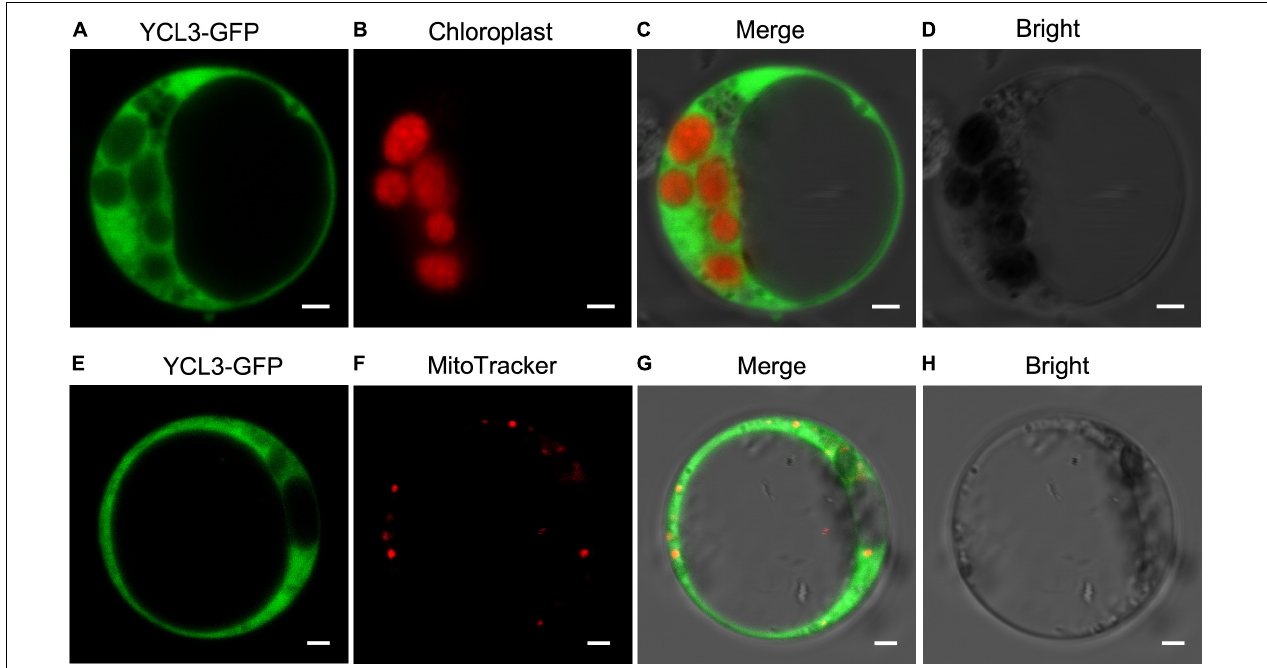
FIGURE 7 | Subcellular localization of YLC3-sGFP. (A–D) Transient expression of YLC3:sGFP in rice protoplasts. (A) GFP. (B) Chlorophyll autofluorescence. (C) Merged images of (A,B) . (D) Bright field. (E–H) Transient expression of YLC3:sGFP and MitoTracker staining of transfected protoplasts. (E) GFP. (F) Mitochondrial fluorescence staining by MitoTracker. (G) Merged images of (E,F) . (H) Bright field.